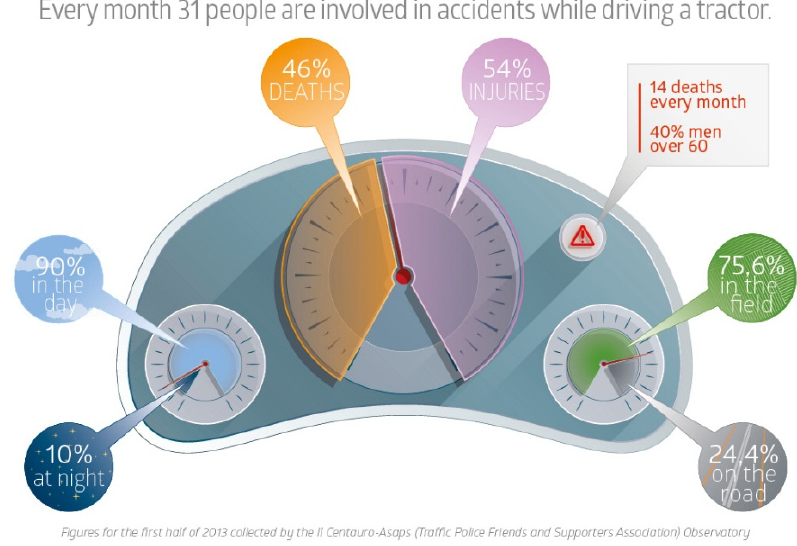
Figure 9. Example of graphic information on the latest data on accidents.